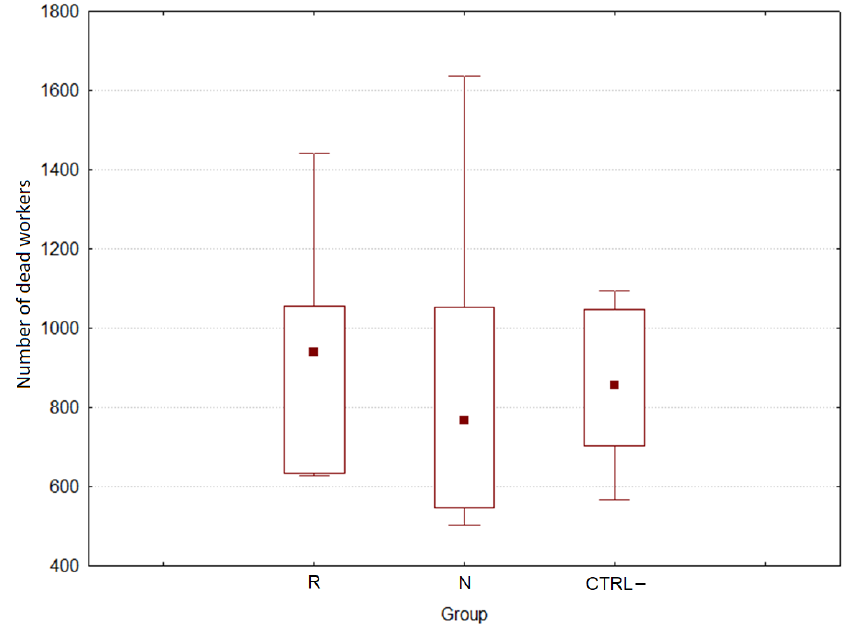
Figure 1. Bee workers cumulative mortality from the three groups (R: E. sativa , N: B. nigra , CTRL–: negative control) during feeding trials of 28 days.